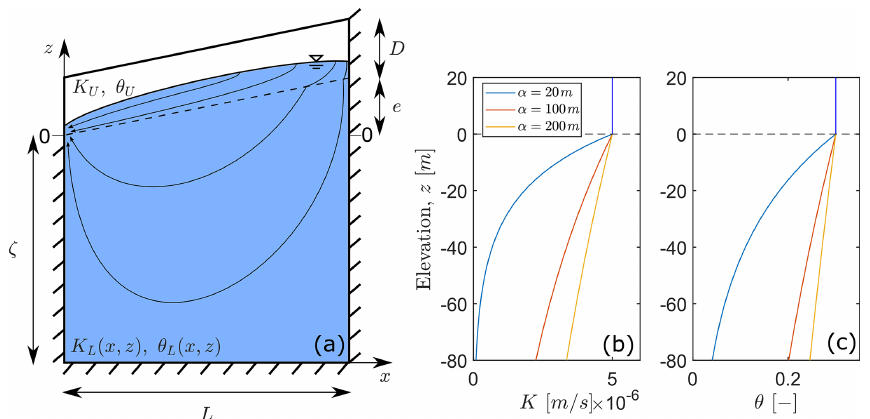
Figure 2. (a) A 2D model cross section with the main geometrical parameters identified along with model boundaries and groundwater flow lines. Panels (b) and (c) are vertical profiles taken at x = 0 of K and θ , respectively, for the different α values